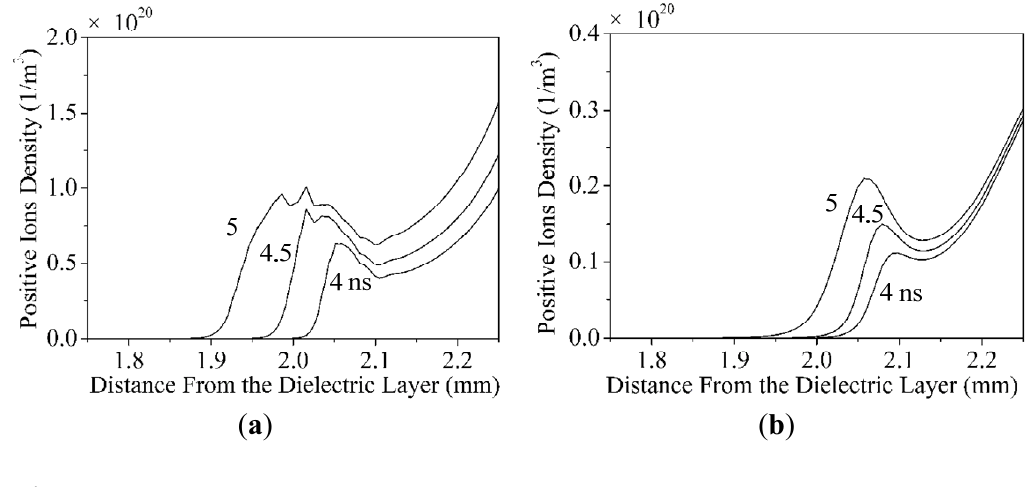
Figure 17. Positive ion density distribution along the axis of symmetry of the